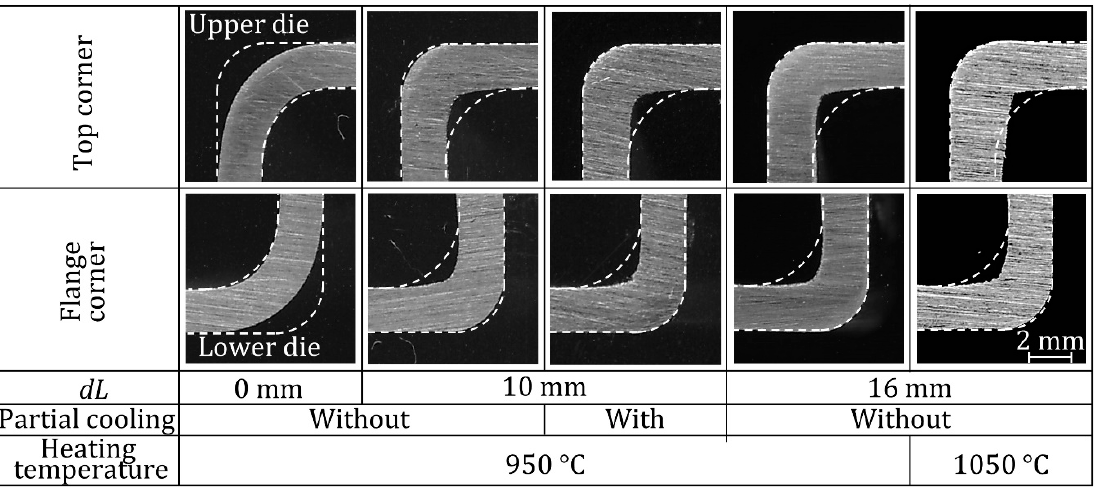
Figure 6. Cross-sections around top and flange corners of hot hat-shaped bent parts. The distributions of change in thickness in the hot hat-shaped bent parts are measured by a micrometre calliper (Mitutoyo, Kawasaki, Japan) and given in Figure 7. The thicknesses around the corners increase with increasing blank length. For L = 110 mm, the thickness of the corners increases by about 30%. Although the rise in heating temperature is effective in the increase in thickening, the heating temperature of 1050 °C is too high for the Al-Si-coated sheet due to the formation of an insufficient oxidation resistance layer. For the planar compression, not only the corners but also the sidewalls are thickened except for partial cooling shown in Figure 3c, while the effect of partial cooling on thickening around the corners is not much.